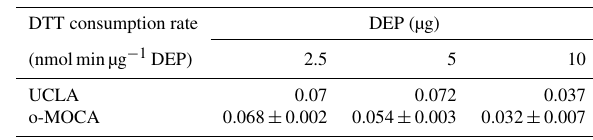
Table 2. Comparison of consumption rates (nmolminµg − 1 DEP) for different DEP amounts obtained at UCLA with the standard DTT assay and